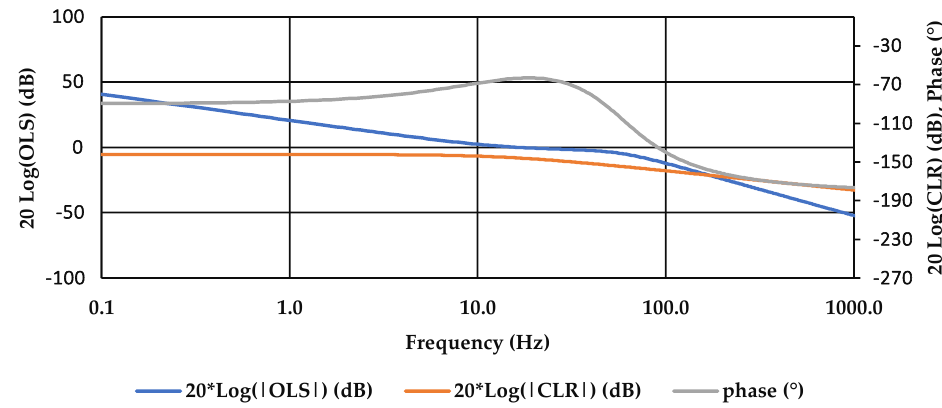
Figure 6. Frequency response for bound system design solution 1.